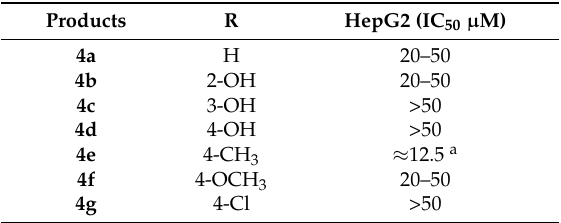
Table 1. Inhibitory effects of the products against HepG2 cell line